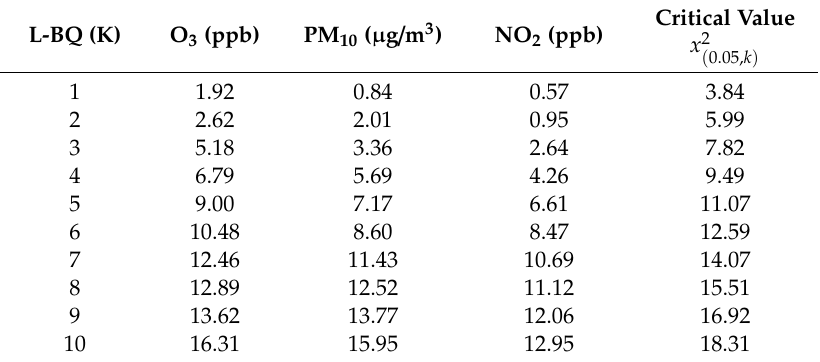
Table 3. Ljung–Box Sequence Test for 3 air